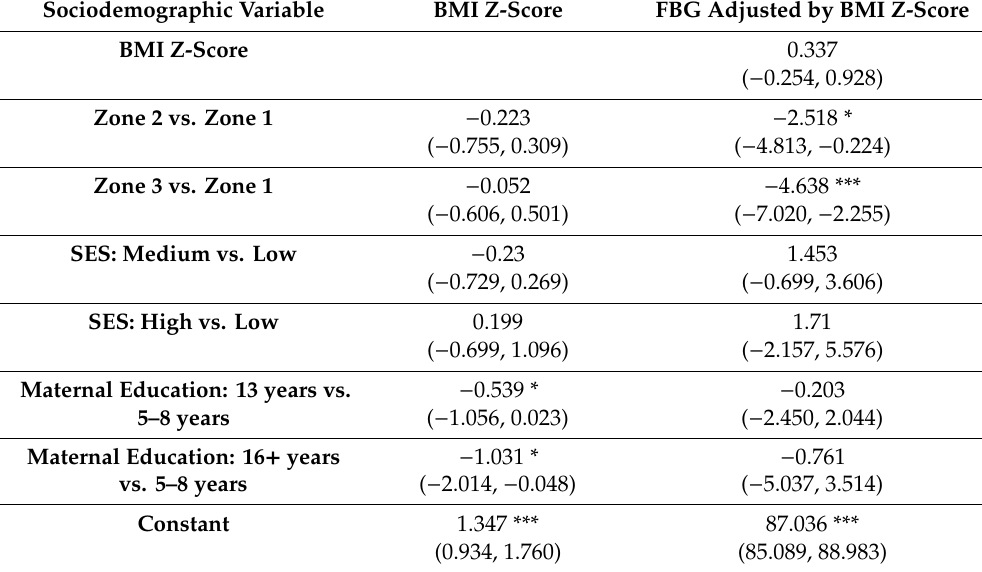
Table 3. All participants ( n = 214): Linear regression coe ffi cients and 95% confidence intervals for associations of (i) residential zone; (ii) socioeconomic status (SES) index; and (iii) maternal